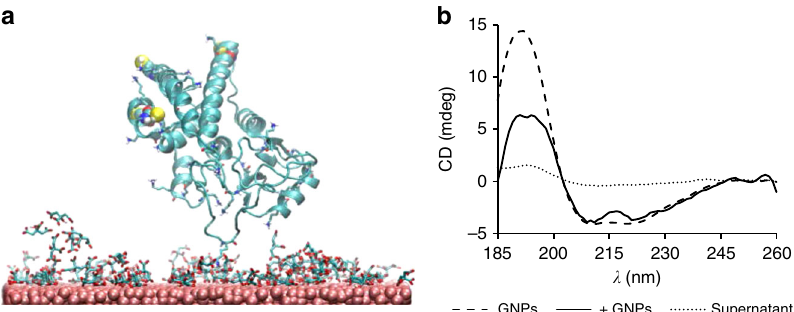
Fig. 3 Rearrangement of GST bound to GNPs. a Representative conformation after 20 ns MD simulation of GST (PDB ID: 1UA5) bound to citrate-capped gold surface. GST has rotated compared to the original position (Supplementary Figure 4B) to orient lysine residues toward the citrate on the surface. Positively charged residues and cysteines are shown as stick and van-der-Waals representation, respectively. The complete simulation space of this and two other simulation events is reported in Supplementary Figure 4C-E. Supplementary Figure 4F also shows that there are no evident secondary structure changes within 20 ns of simulation. b SRCD spectra in the far UV region of GST in solution (dashed line) compared to GST bound to GNPs (solid line) measured at the same concentration. The latter was incubated with excess GST for 1 h and extensively washed before measurement to avoid the presence of protein in solution. After measurement GNPs were removed by centrifugation and a spectrum of the supernatant only (dotted line) was acquired and showed that little, if any, protein was present in solution, con fi rming that the spectrum of GST/GNPs was representative of the conformation of GST on gold surface. Similar measurements conducted on silver colloid are shown in Supplementary Figure